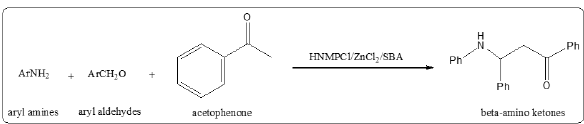
Figure 6: Three-component Mannich reaction of various aryl